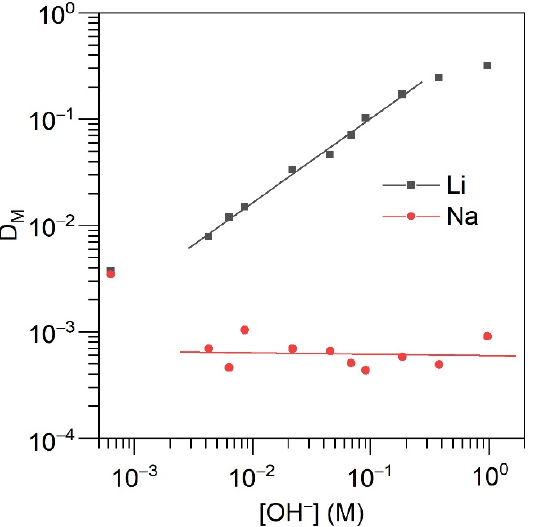
Figure 6. Influence of [OH − ] on lithium extraction. Aqueous phase: [Li + ] = 0.5 g L − 1 ; organic phase: [HL] = 0.05 mol L − 1 , [TOPO] = 0.05 mol L − 1 ; temperature = 25 °C. O/A = 1/1.